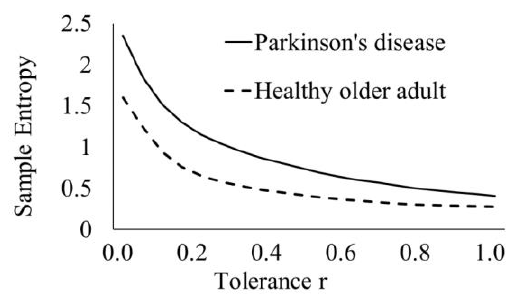
Figure 4. Sample entropy of stride time as a function of tolerance r for averaged m = 1 , 2 , 3 , 4 for a participant with Parkinson’s disease (PD1) (solid line) and a healthy older adult (HOA1) (dashed line).